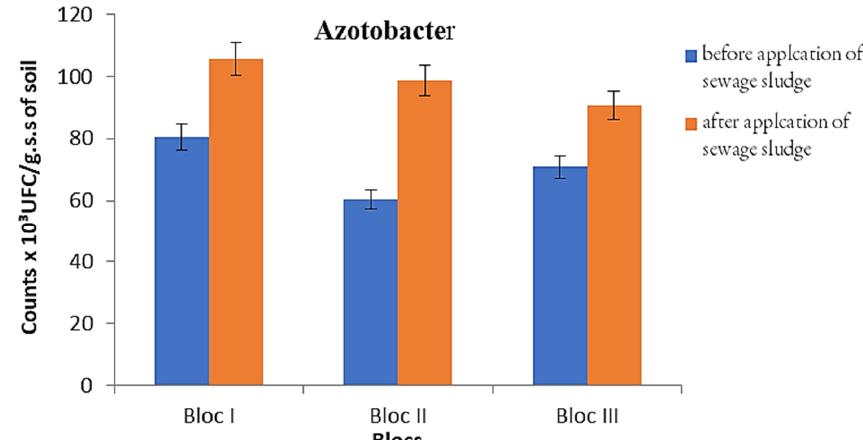
Figure 4. The average of total Azotobacter count of the soil before and after application of sewage